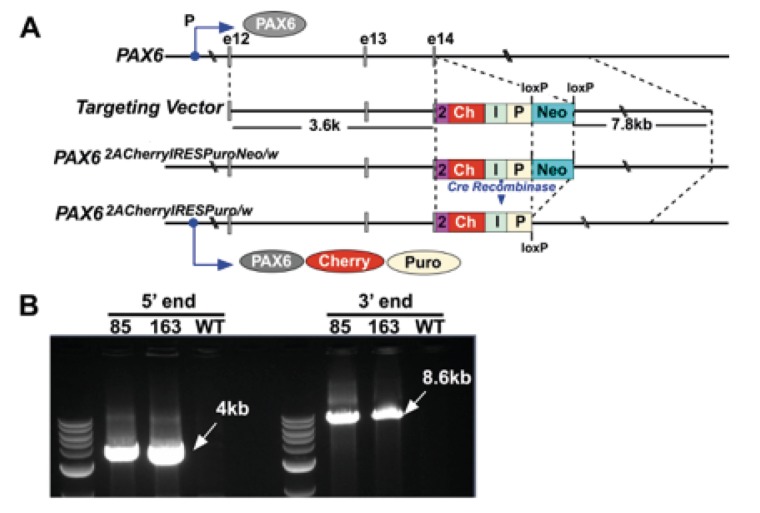
Targeting of the PAX6 gene with an mCherry-Ires-Puro reporter cassette.(A) Structure of the PAX6 targeting vector. The upper line shows the endogenous PAX6 gene with exons (and exon number, e12, e13, e14) indicated by grey boxes. The second line shows the targeting vector with its constituent components, from left to right, the 5’ homology arm, a T2A sequence (2), mCherry (Ch), IRES (I), puromycin resistance gene (P), a loxP flanked PGKNeo cassette (Neo) and the 3’ homology arm. The third line shows the structure of the modified PAX6 locus following integration of the targeting vector. The forth line shows the modified PAX6 locus following cre-recombinase mediated removal of the PGKNeo selection cassette. The protein products predicted to be translated from this locus, PAX6, mCherry and Puromycin resistance, are shown underneath. (B) PCR analysis confirming correct integration of the targeting vector in two independent clones (85, 163). Note these PCR products of the correct size were not generated when wild type (wt) was used as a template.